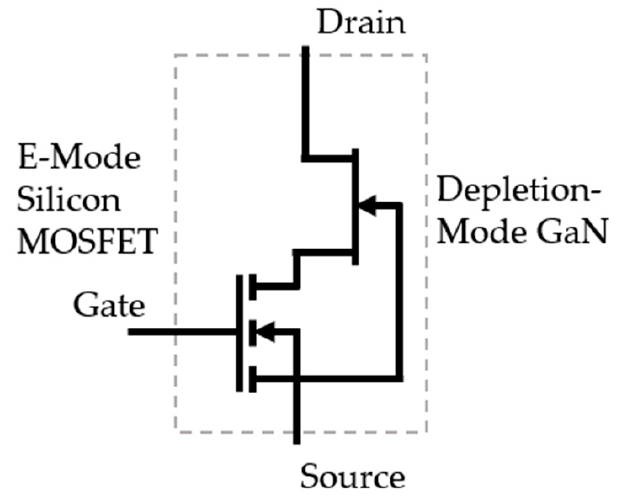
Figure 2. Cascode GaN HEMT made by an enhancement-mode n-channel silicon MOSFET in series with a depletion-mode GaN HEMT.